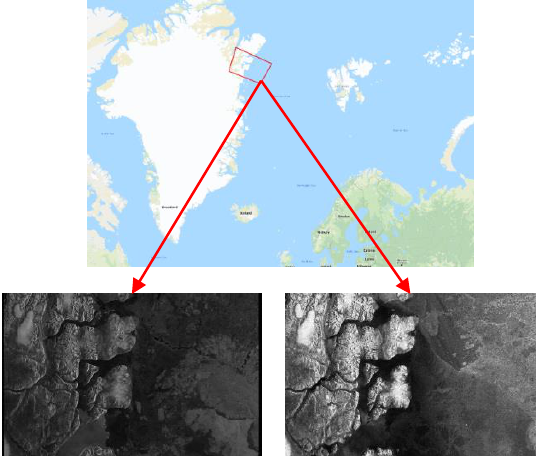
Figure 1. The location of the area of interest (top), the quick- look of the Sentinel-1 data acquired on April 17 th , 2018 (bottom-left), and the quick-look of the Sentinel-1 data acquired on June 16 th , 2018